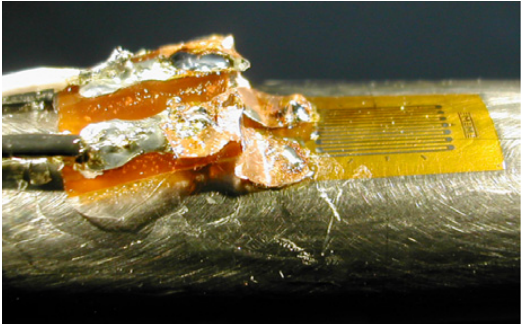
Fig. 5. Copper foil soldered to connection tab and the strain gage’s tab after failure.